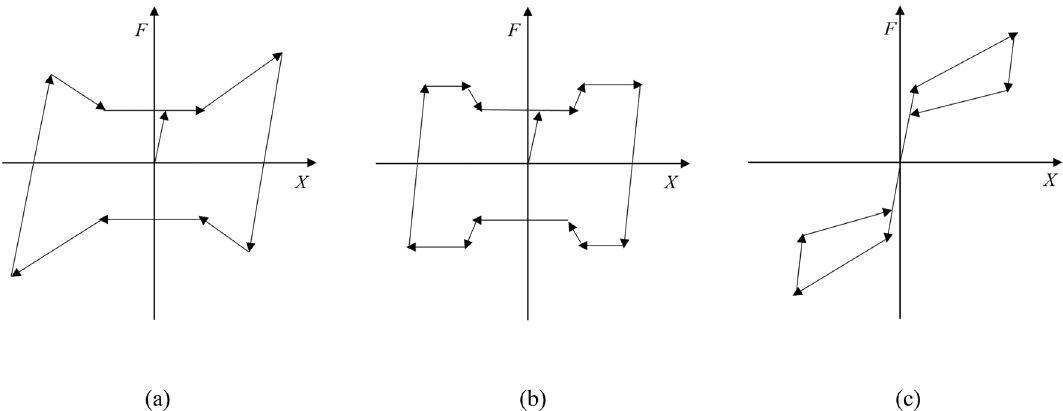
Fig. 1 Hysteretic patterns of typical passive variable friction dampers: a Butterfly hysteresis; b Double-platform hysteresis; c Dual-flag hys-